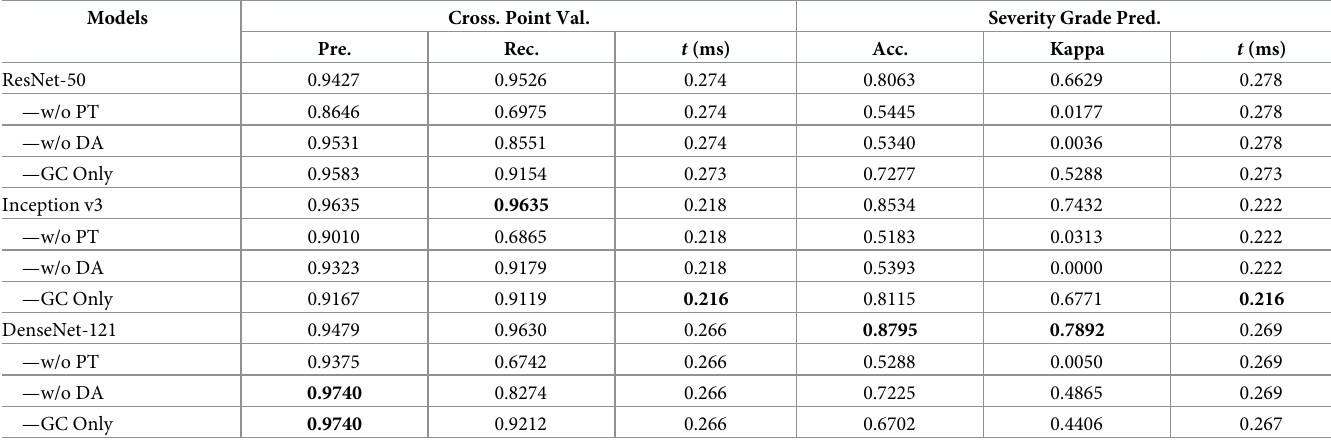
Table 1. Performances of base models with ablation. Models Cross. Point Val.